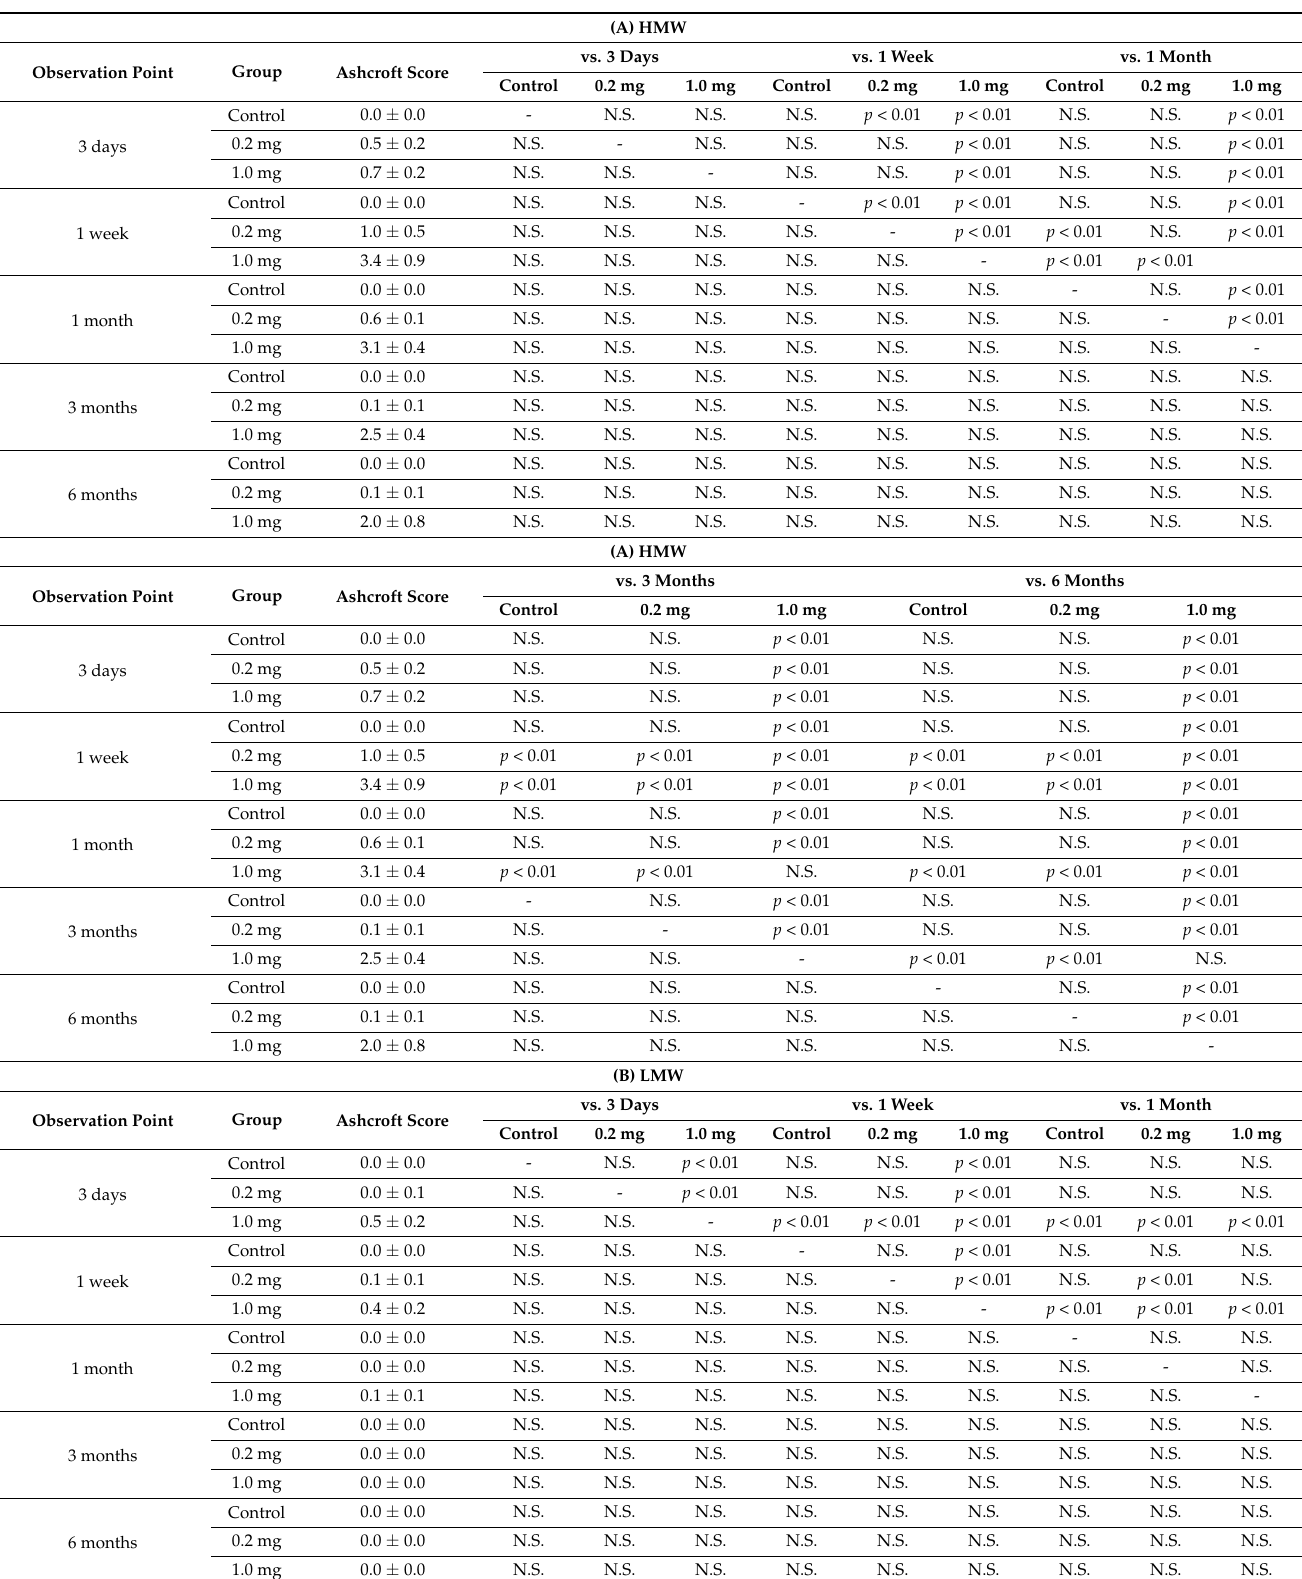
Table A1. The results of the Ashcroft score of lung